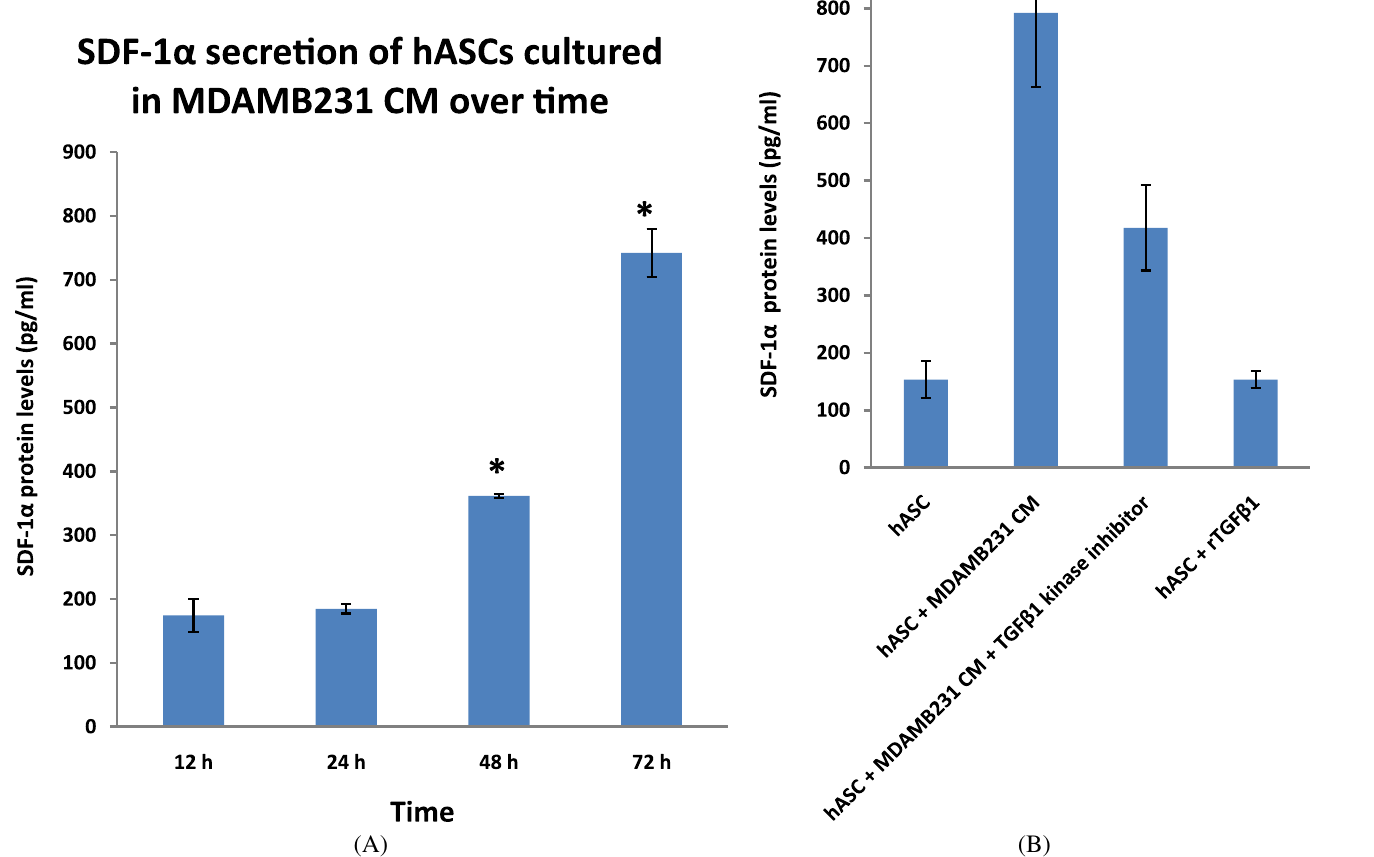
Fig. 5. Tumor conditioned medium stimulates the secretion of SDF-1 α from hASCs. (A) Protein levels of SDF-1 α secreted from hASCs exposed to MDAMB231 conditioned medium over time (12–72 h) was measured by ELISA. The experiment was repeated three times. * P < 0 . 0001 versus 12 h MDAMB231-CM. (B) Serum-starved hASCs were pretreated with vehicles, or 10 µM SB431542 (TGF β 1 receptor kinase inhibitor) and then cultured in serum-free regular medium, MDAMB231 conditioned medium or exposed to 0.2 ng/ml rTGF β 1 for 72 h. Cell culture supernatants were subjected to ELISA for the measurement of SDF-1 α levels. Data represent mean ± SD ( n = 3). * P < 0 . 001, ** P < 0 . 01. SDF-1 α – stromal-cell-derived factor 1 alpha; rTGF β 1 – recombinant transforming growth factor beta 1. (The colors are visible in the online version of the